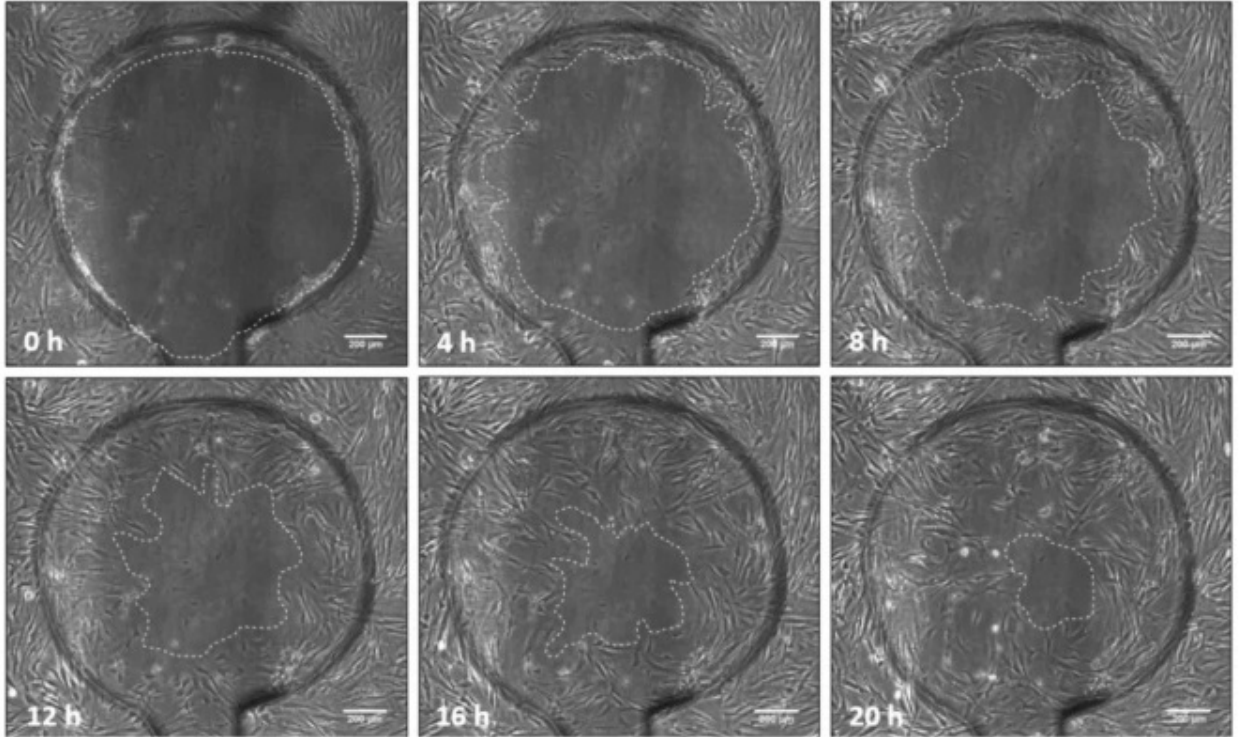
Figure 6. Evaluation of fibroblasts migration and wound closure using microfluidic device based wound assay at different time points under through time lapse images under standard experimental conditions. Reproduced from Ref. [265] with permission from Nature Publishing Group. This work is licensed under a Creative Commons Attribution 4.0 (CC BY) International License.